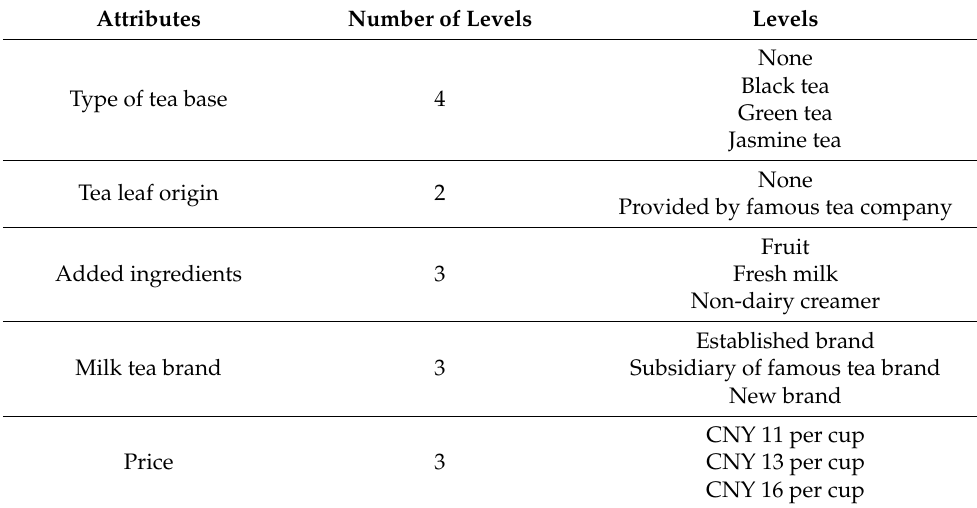
Table 1. Product attributes and levels in the choice experiment.